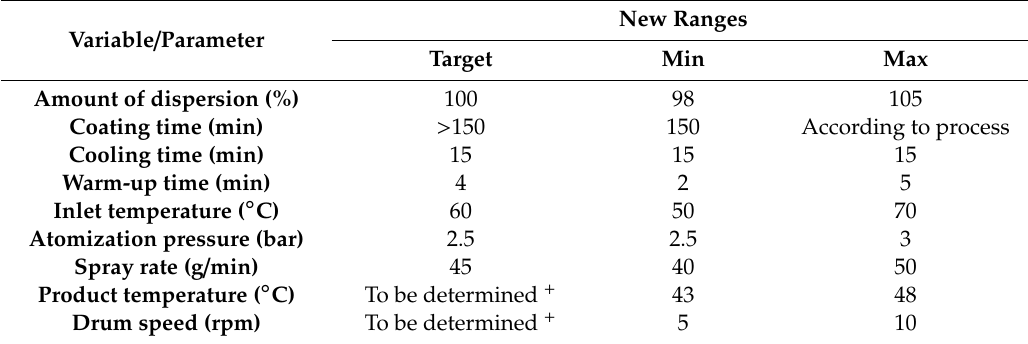
Table 1. Proposed process parameter values according to the previous retrospective analysis of the